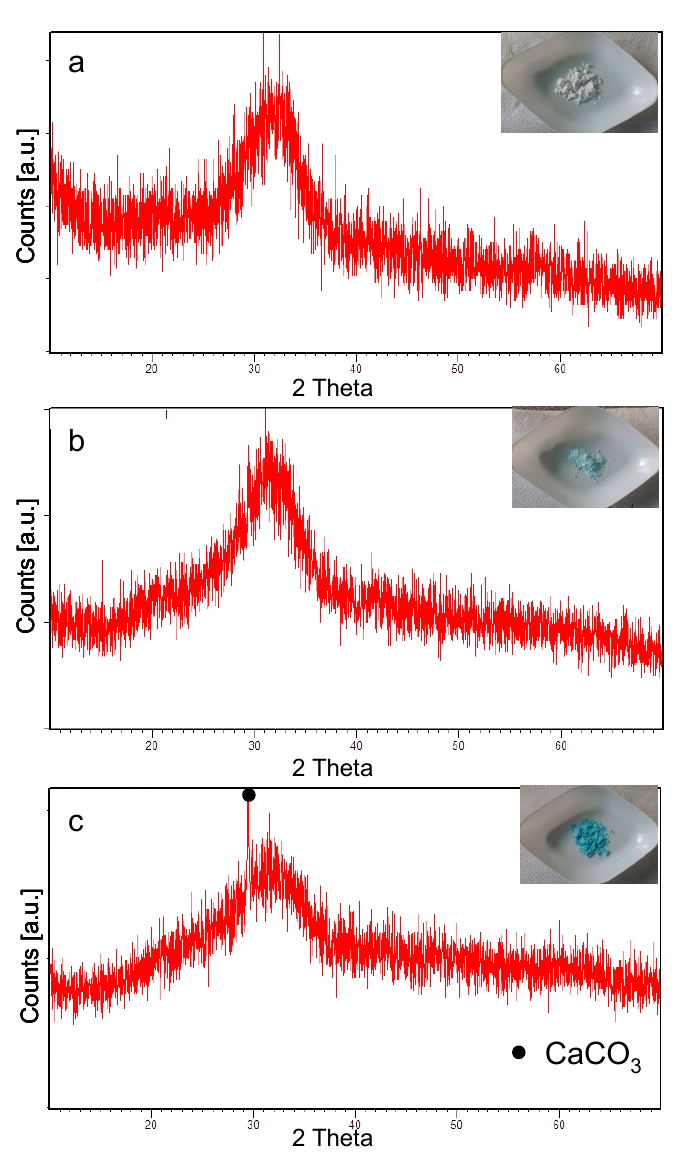
Figure 6. XRD analyses of SBA3 ( a ) before ion exchange; and after ion exchange in copper (II) acetate solution ( b ) 0.01 M and ( c ) 0.05 M.